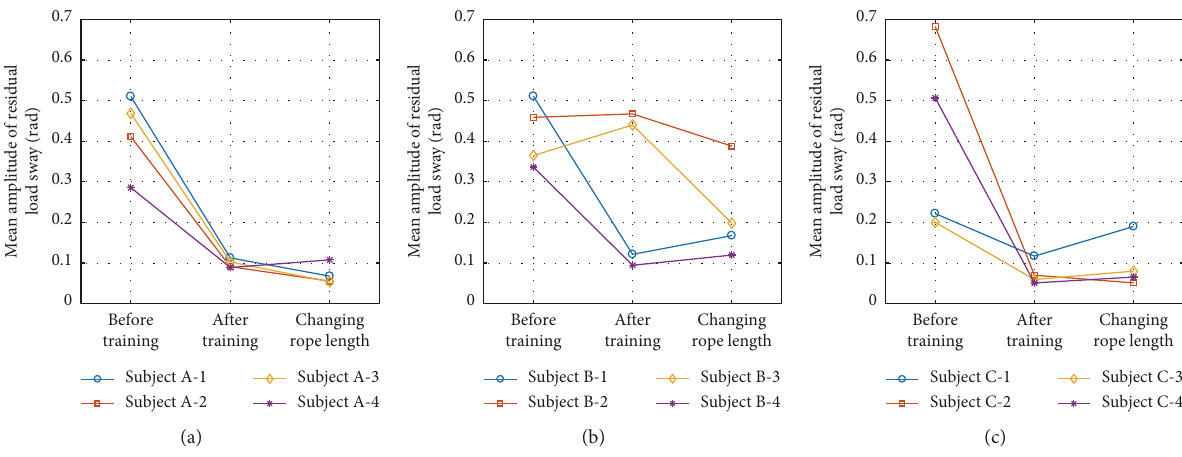
Figure 11: Mean amplitudes of residual load sway in attempts. (a) The results of which the subjects train the crane operations with displaying the sway angle conditions shown in Figure 7. (b) The results of which the subjects train the crane operations without displaying operational instructions. (c) The results of which the subjects train the crane operation with displaying the time-series graph shown in Figure 9. The results of each subject are associated with the colored line.